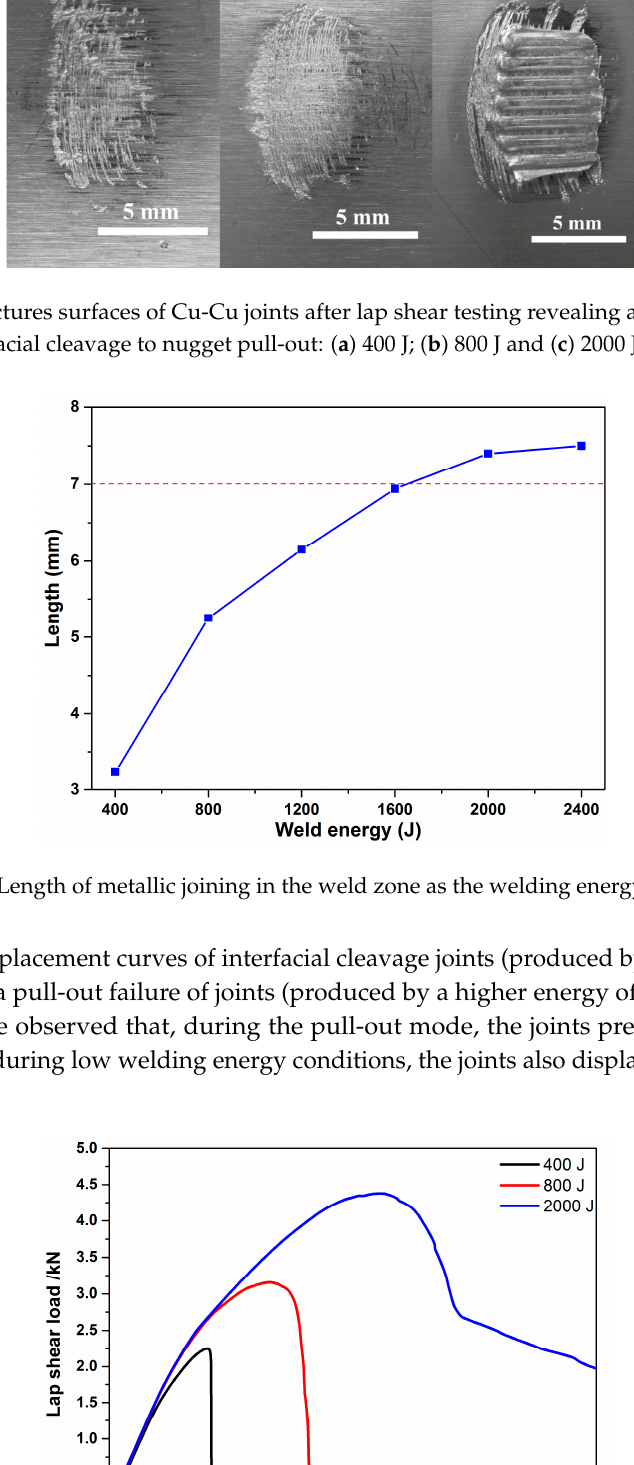
Figure 9. The lap shear load–displacement curves recorded for various welding energies.